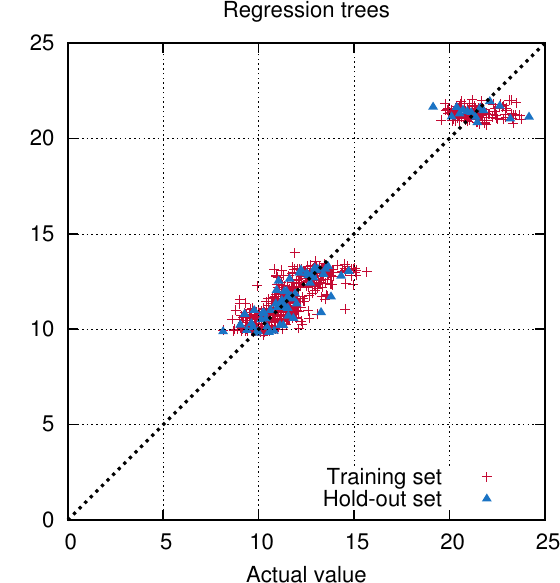
Figure 10. Comparison of the measured and predicted values of R z for the training and hold-out set, using the best found regression tree model.